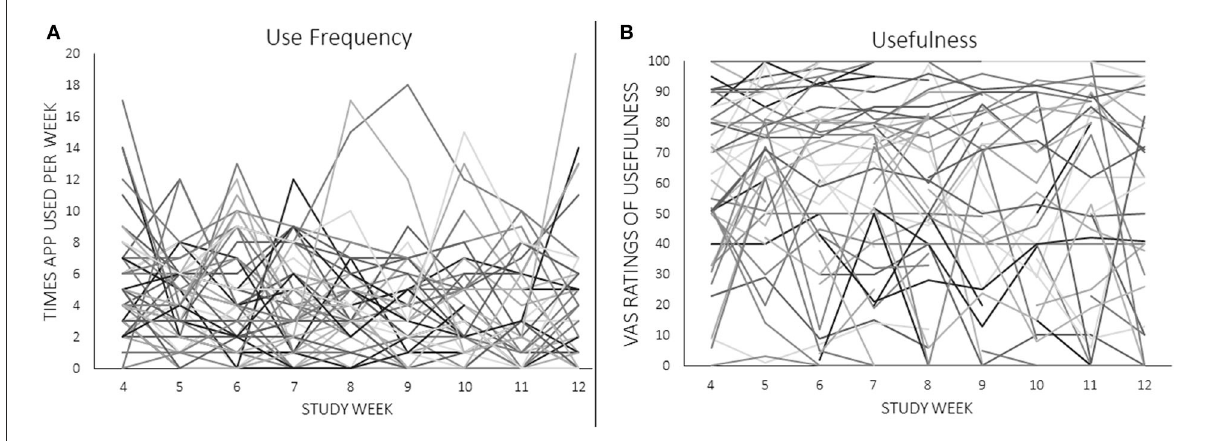
FIGURE3 (A,B) Individual trajectories of app use frequency and ratings of usefulness across the 8-week intervention. Raw values of VAS ratings are shown.